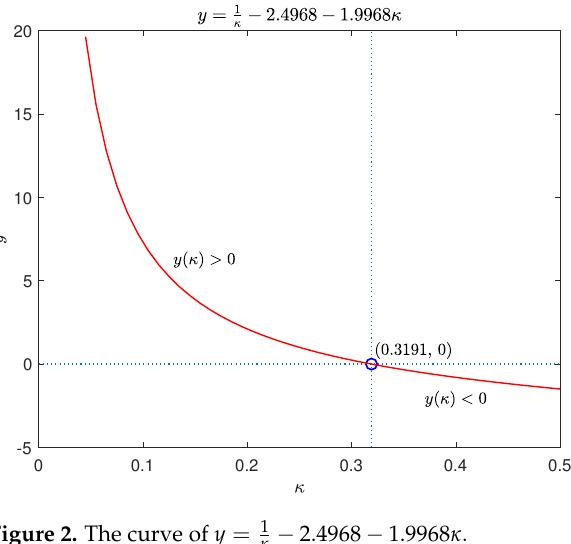
Figure 2 shows the change curve of y = 1 we can take 0 < κ < 0.3191 such that (31) holds.